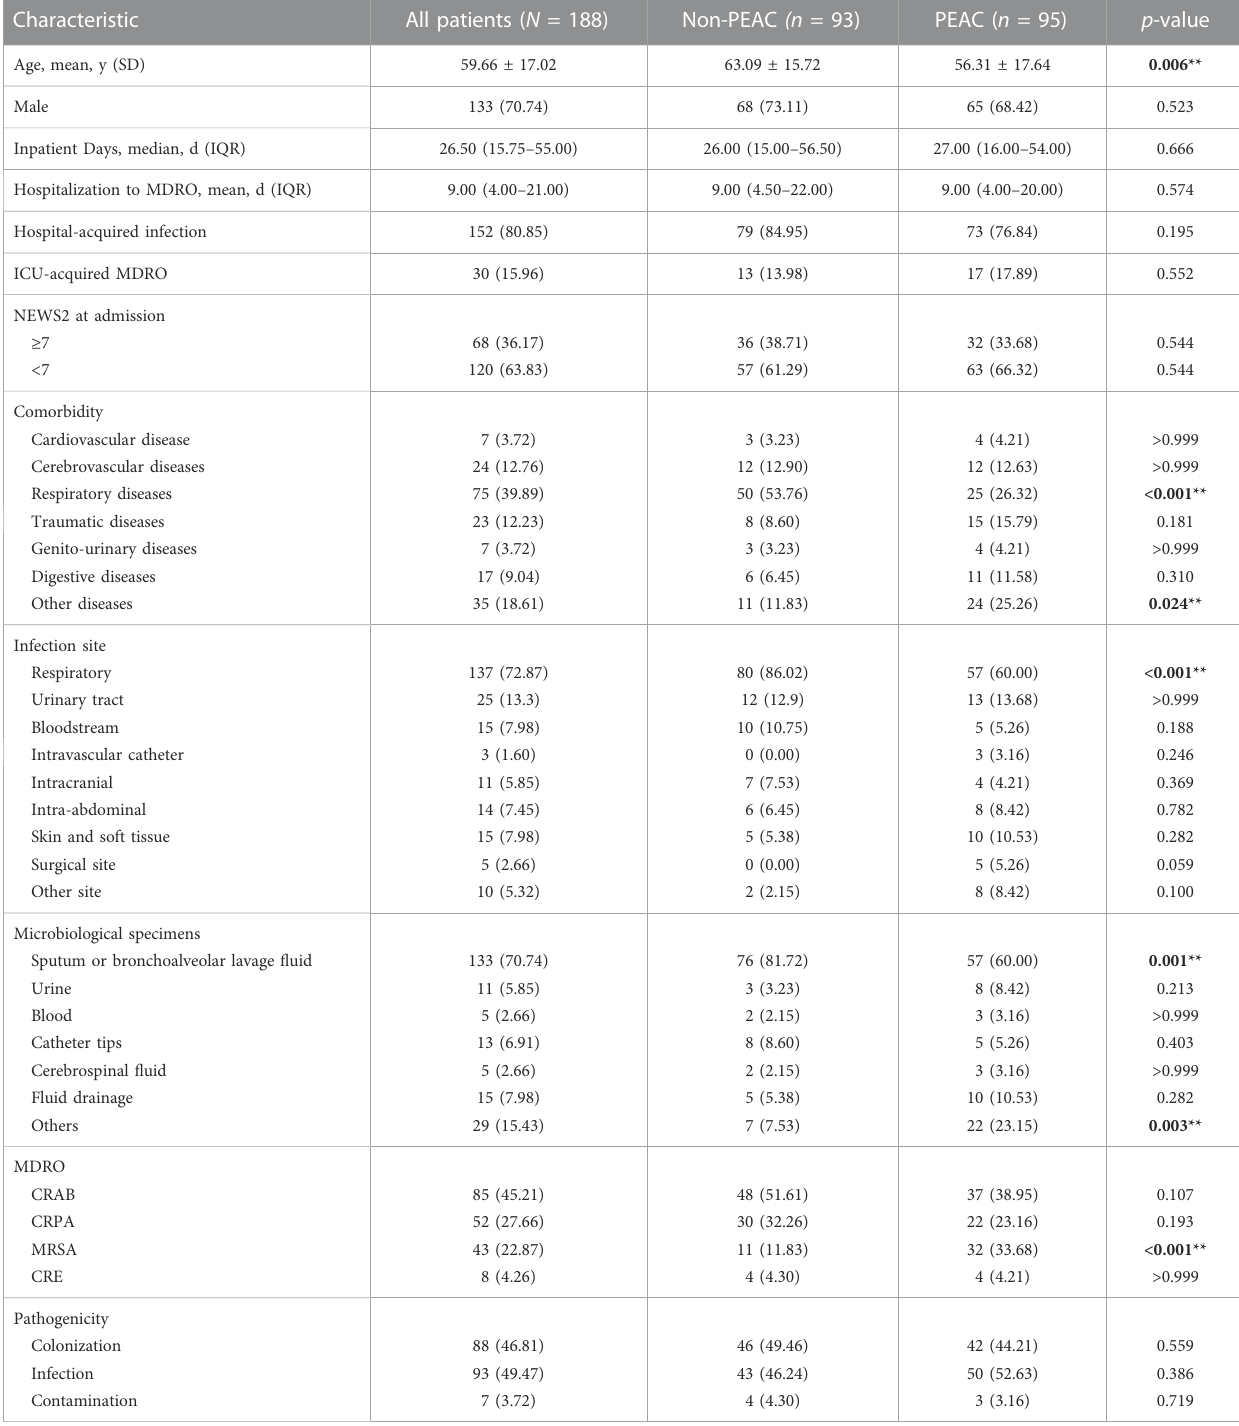
TABLE 1 Characteristics of the patients at the baseline.